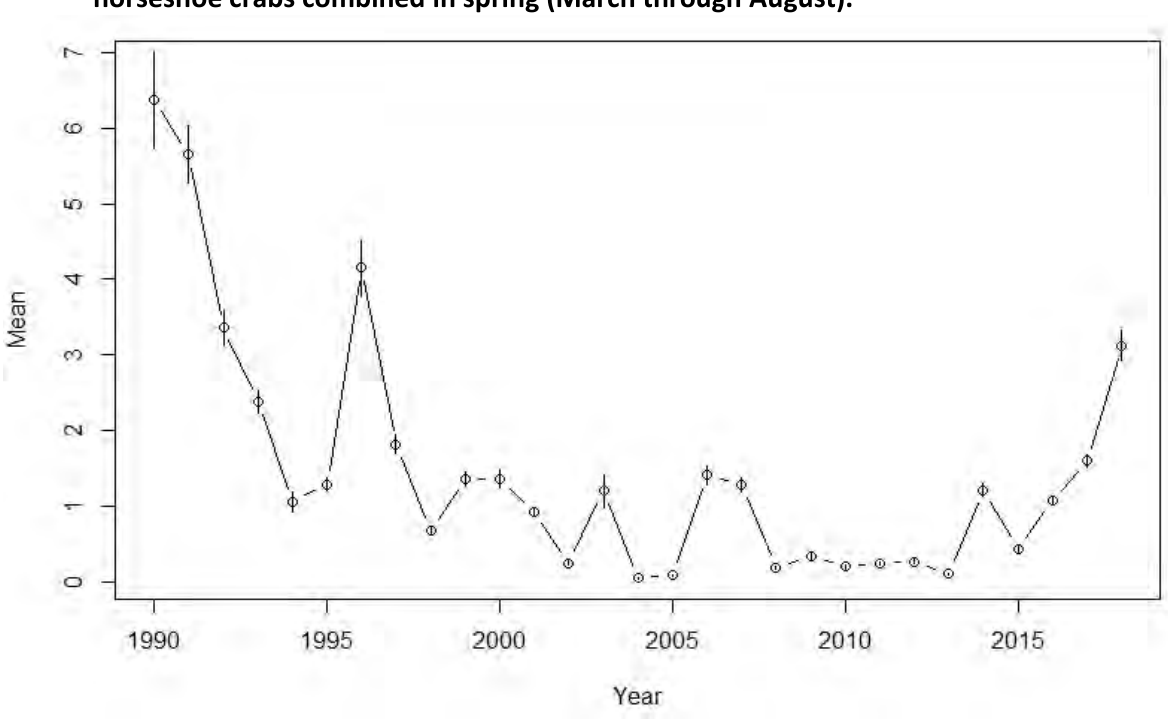
Figure 54. Delaware Fish and Wildlife Adult Trawl Survey abundance index for all adult female horseshoe crabs in spring (March through